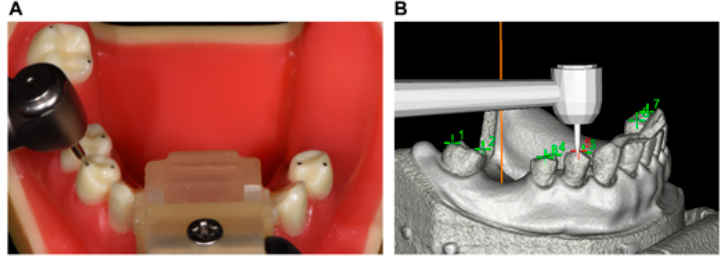
Figure 3. The process of cusp registration in oral ( A ) and software ( B ).